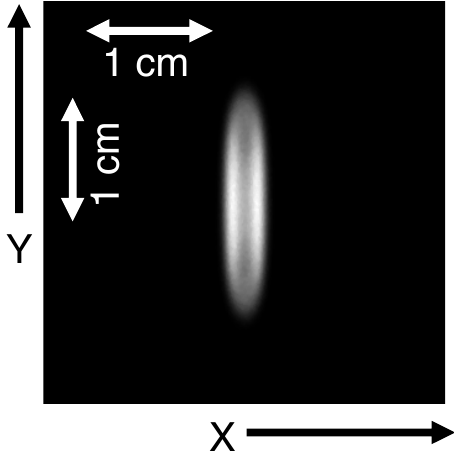
FIG. 7. Spatial distribution of the 7 mA electron beam starting with a Gaussian velocity distribution.